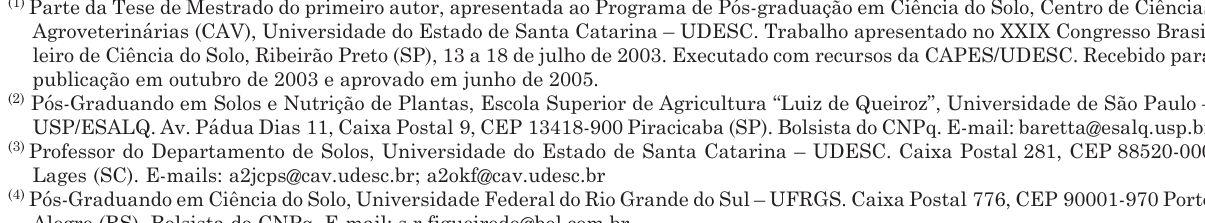
Figueiredo (4) & Osmar Klauberg-Filho (3)